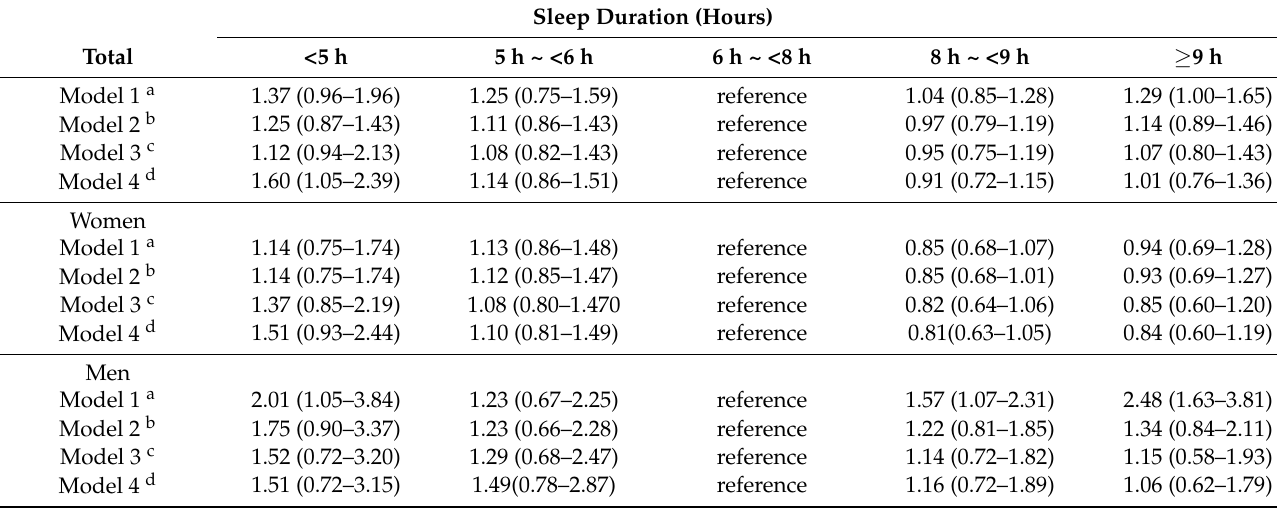
Table 3. Crude and adjusted odds ratios for sleep duration associated with anemia according to various statistical models.